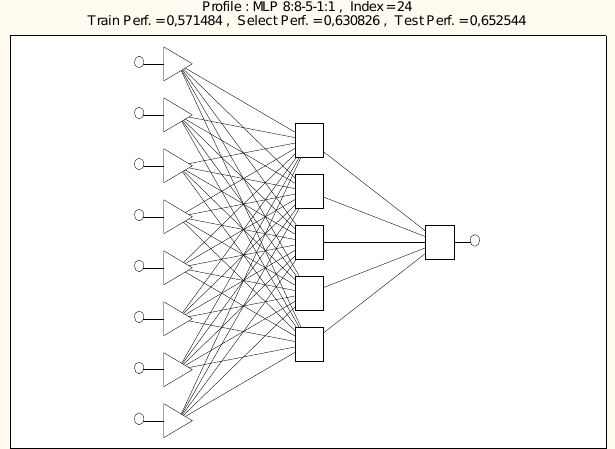
Fig. 1. An example of a two-layered feed-forward neural network model for the quantification of electricity price expectations. The architecture of the MLP (Fig. 1) is composed of an input, one hidden and output layers. Each layer consists of a certain number of units. The number of units in the input layer is chosen based on the results of the correlation analysis. The number of units in the hidden layer is chosen by trials and errors, selecting several options and then running simulations to find the network with the best results, as it was done by J. P. S. Catalão et al . (2007). The output layer consists of a single unit, which is the electricity